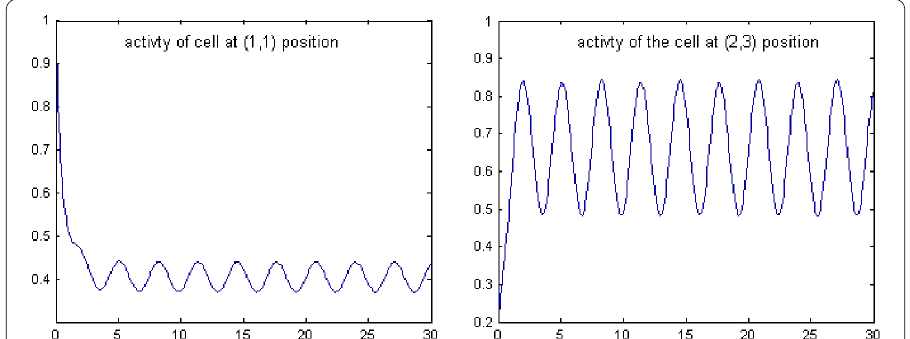
Figure 1 Numerical solutions of x 11 ( t ) and x 23 ( t ) of Example